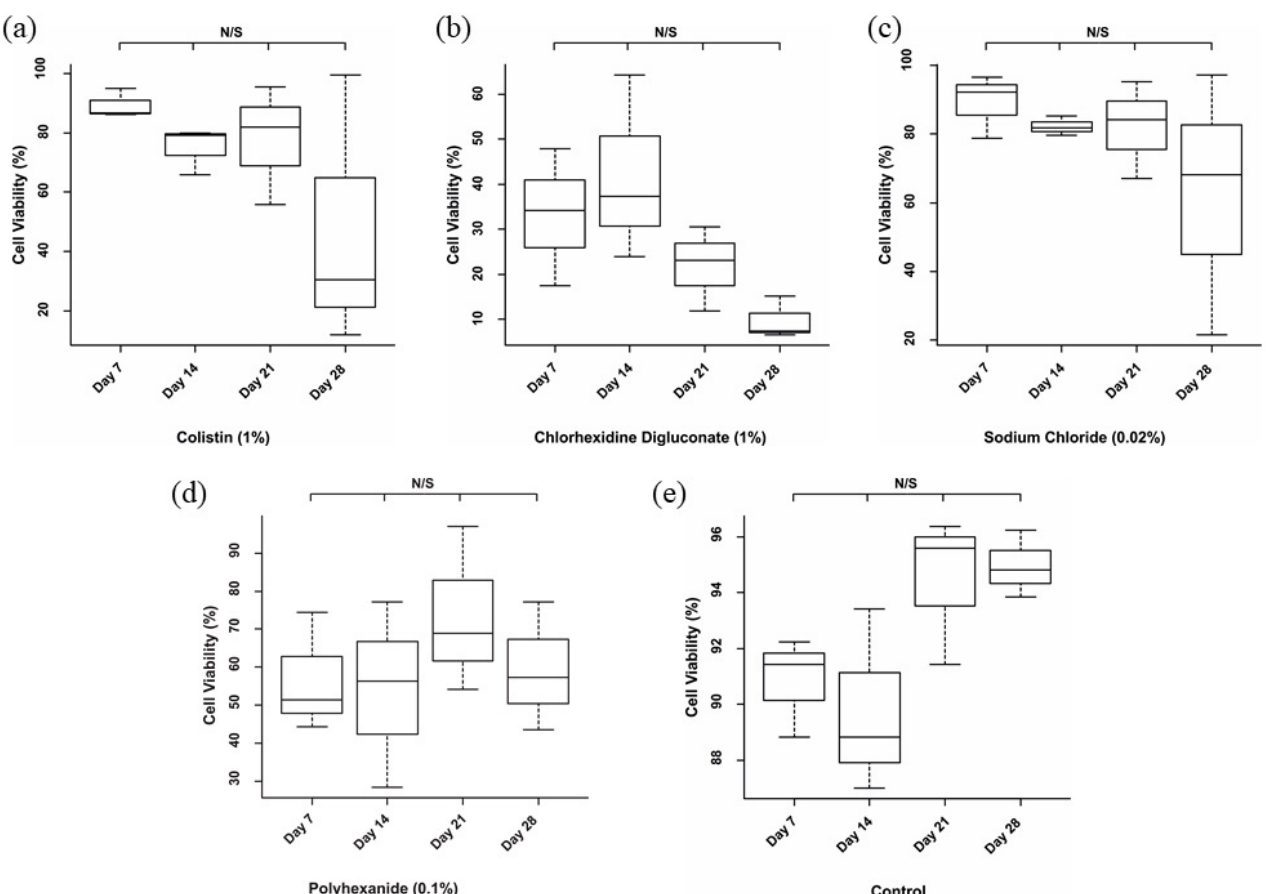
Figure 6. Individual statistical analysis of antiseptic/antibiotic viability test. Boxplot of cell viability percentage after ( a ) colistin (1%) treatment, ( b ) chlorhexidine digluconate (1%) treatment, ( c ) sodium chloride (0.02%) treatment, ( d ) polyhexanide (0.1%) treatment, and ( e ) for the control. n = 3. N/S: no significant differences.